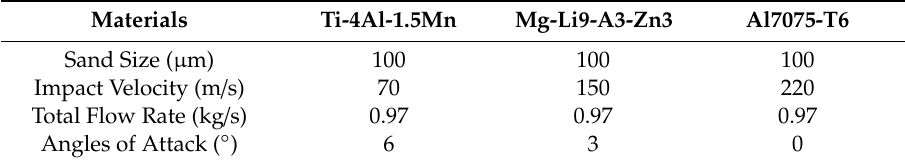
Table 2. Materials and parameters.